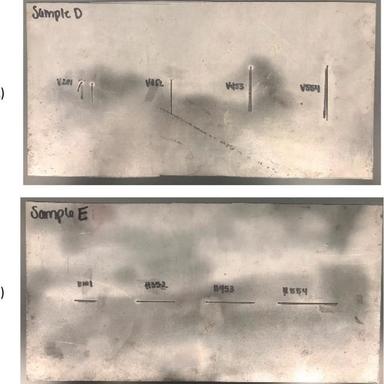
Calibration samples with waterjet-made notched in (A) vertical and (B) horizontal directions..